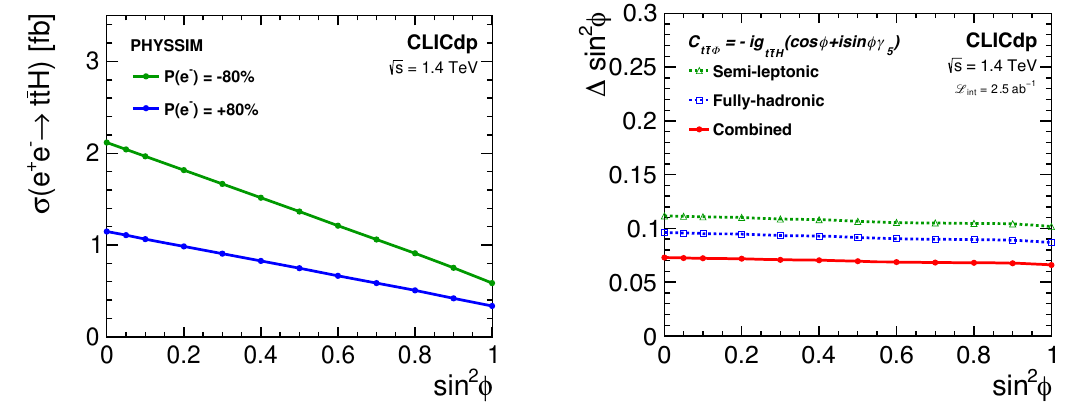
p Figure 23. Cross section for the process e + e (cid:0) ! ttH at s = 1 : 4 TeV including the e(cid:11)ects of ISR and beamstrahlung as a function of sin 2 (cid:30) (left). Sensitivity to the CP mixing angle sin 2 (cid:30) as a p function of sin 2 (cid:30) from the ttH cross section at s = 1 : 4 TeV, assuming an integrated luminosity of 2 ab (cid:0) 1 with -80% electron beam polarisation plus 0.5 ab (cid:0) 1 with +80% electron beam polarisation (right). The sensitivities for both considered (cid:12)nal states are shown separately in addition to the combined